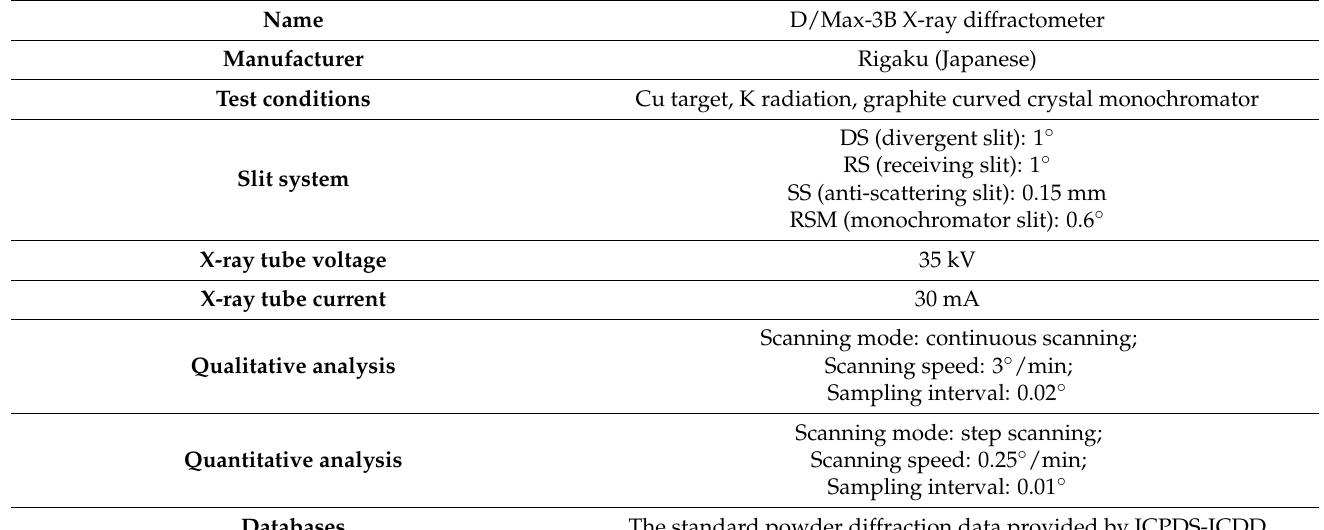
Table 3. The information of the X-ray and the test setup.